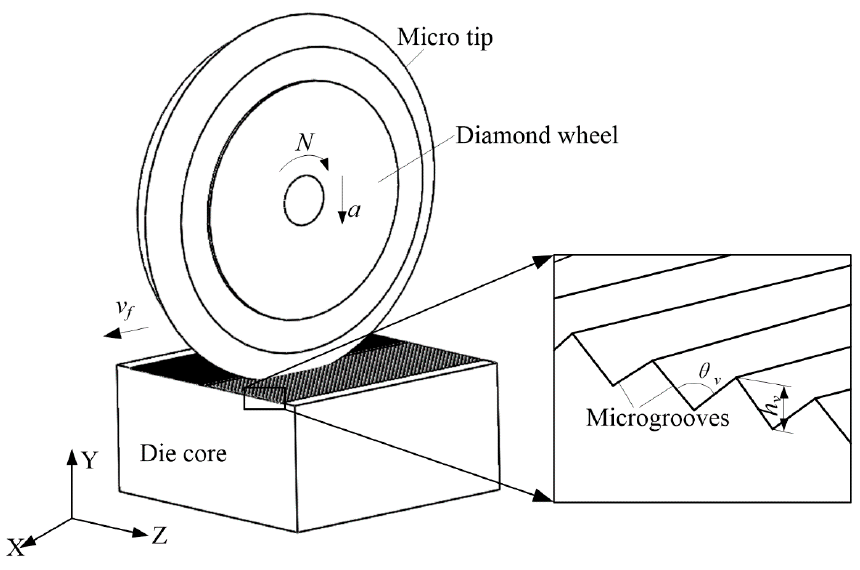
Figure 2. Scheme of microgrinding SiC die core.